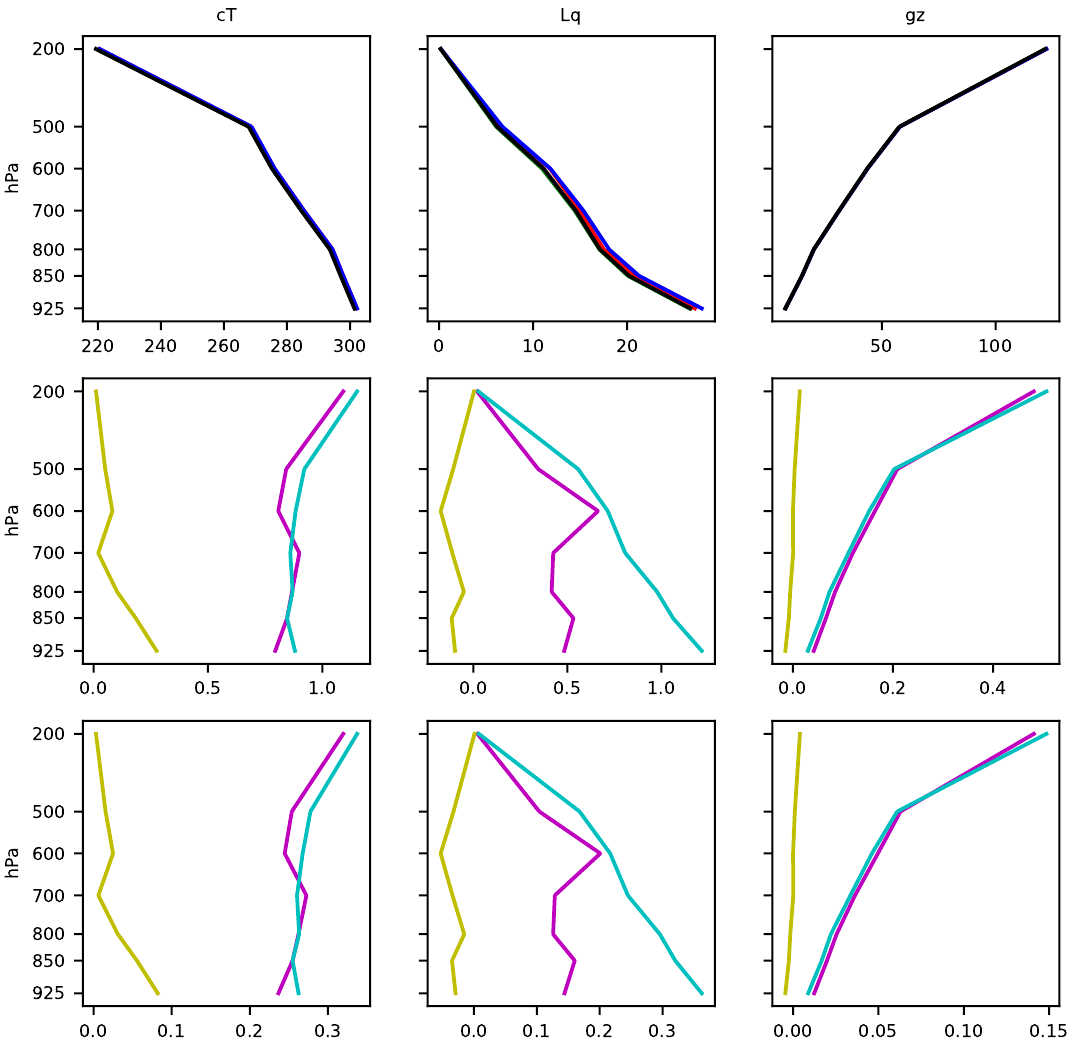
Figure A5. Same as Figure A4 for the Sahel. Note the different horizontal axis